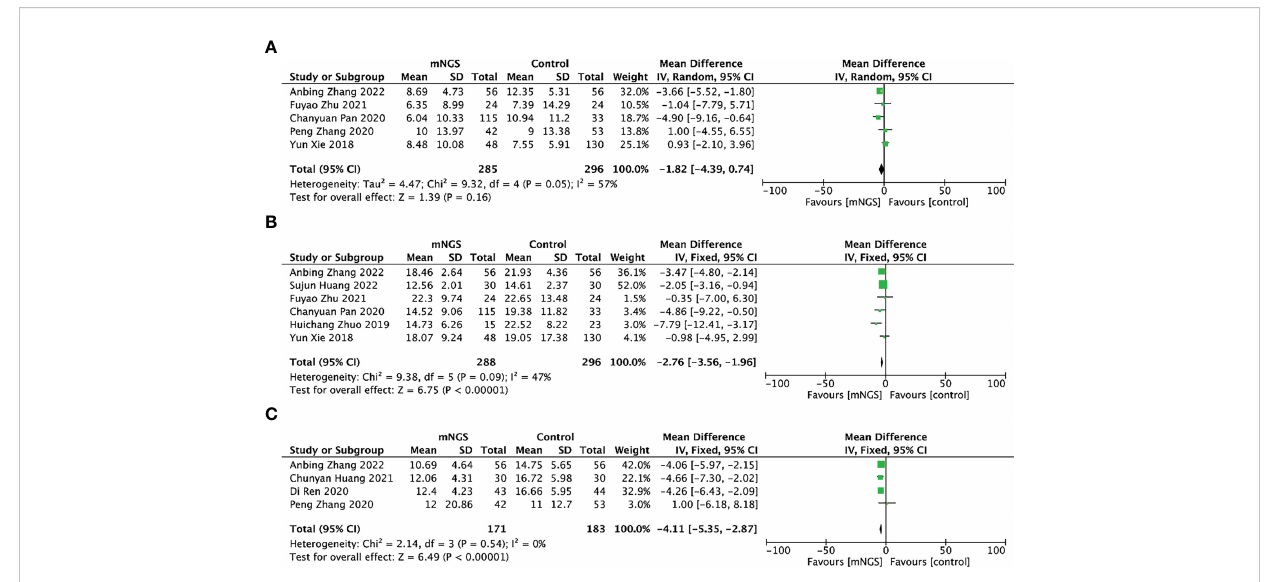
FIGURE 6 Secondary outcomes of the meta-analyses of mNGS compared with conventional methods group: (A) , duration of mechanical ventilation; (B) , length of hospital stay; (C) , length of stay in